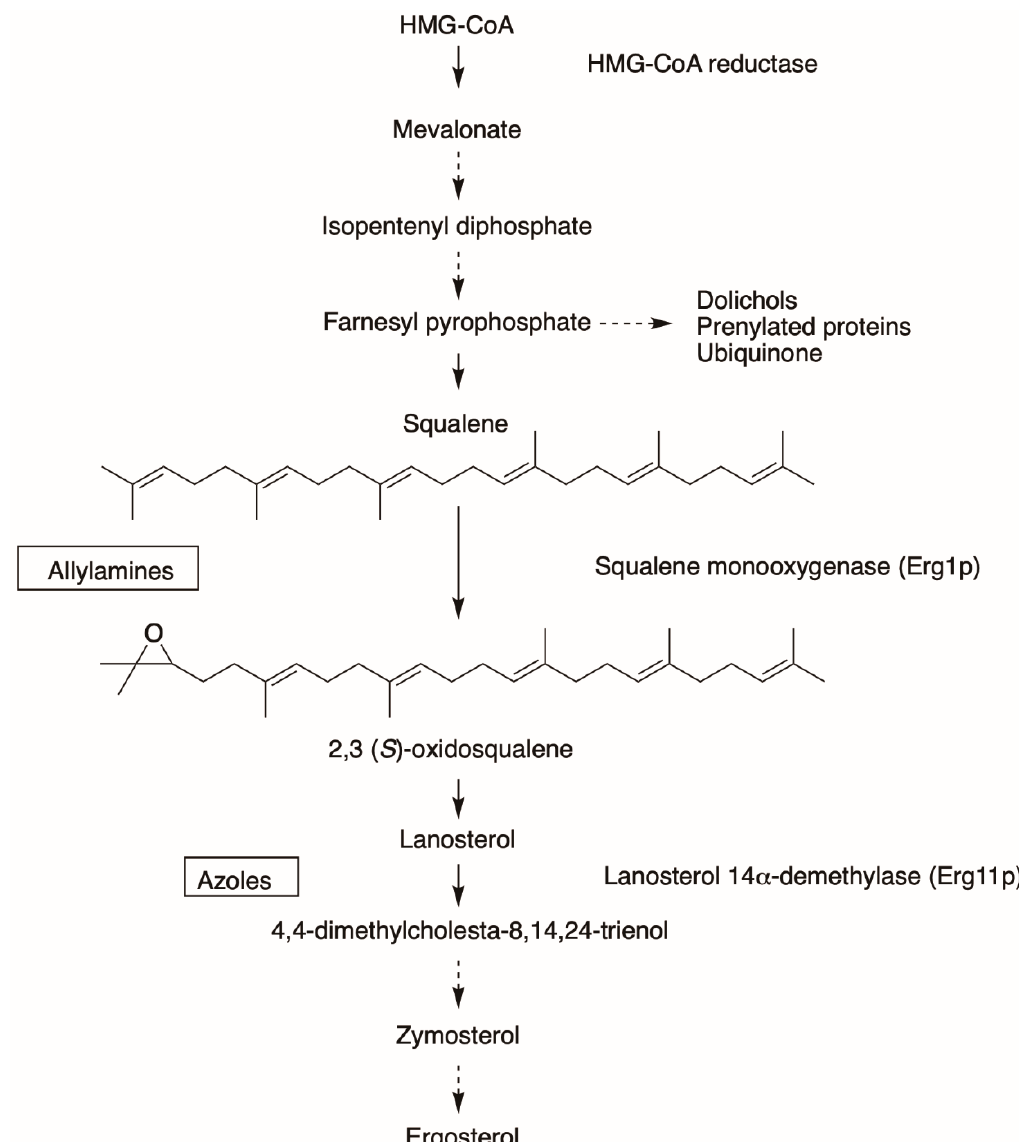
Figure 2. Ergosterol biosynthesis pathway. The simple arrow indicates one catalytic step from substrate to product and the dotted arrow represents presence of several additional catalytic steps.